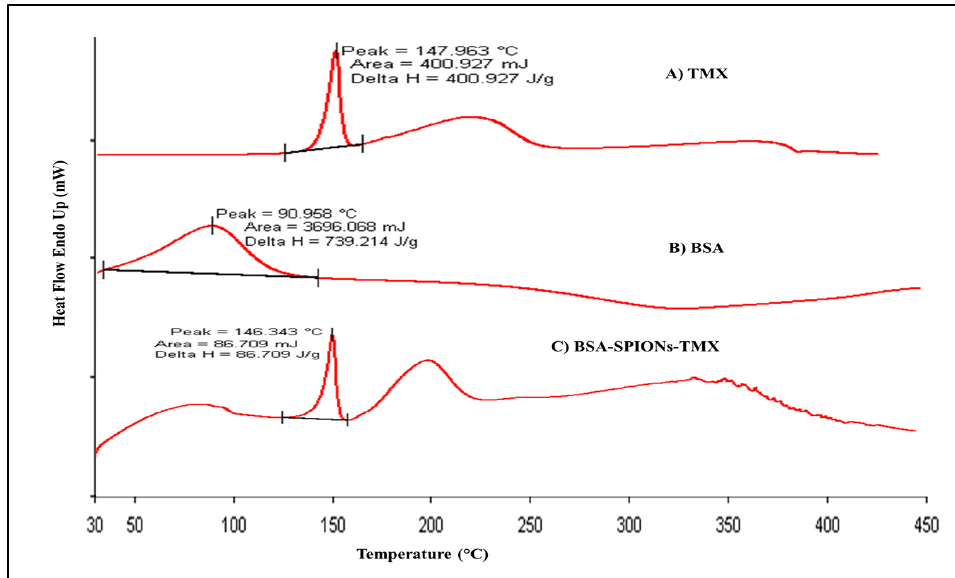
Figure 5. DSC thermogram of TMX, BSA, and BSA-SPIONs-TMX.